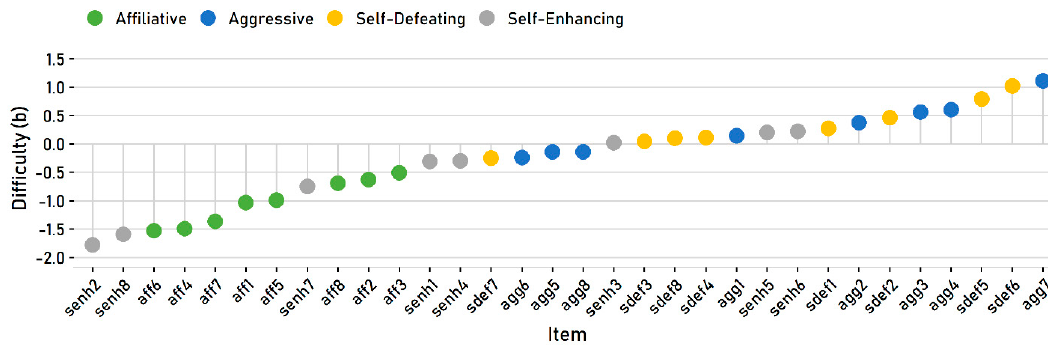
ffi culty values.